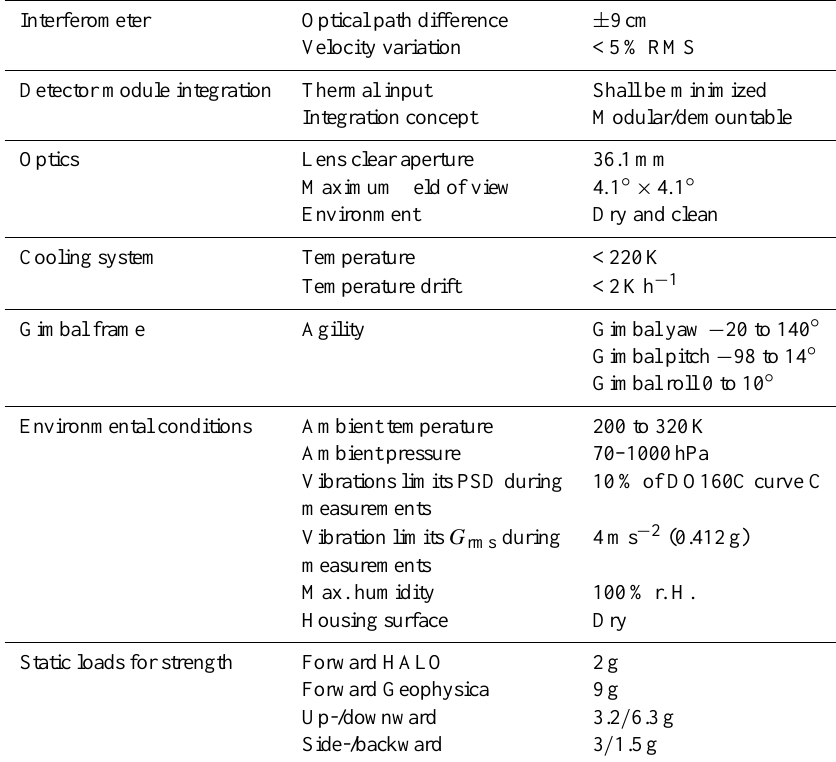
Table 1. Mechanical and thermal requirements for the GLORIA